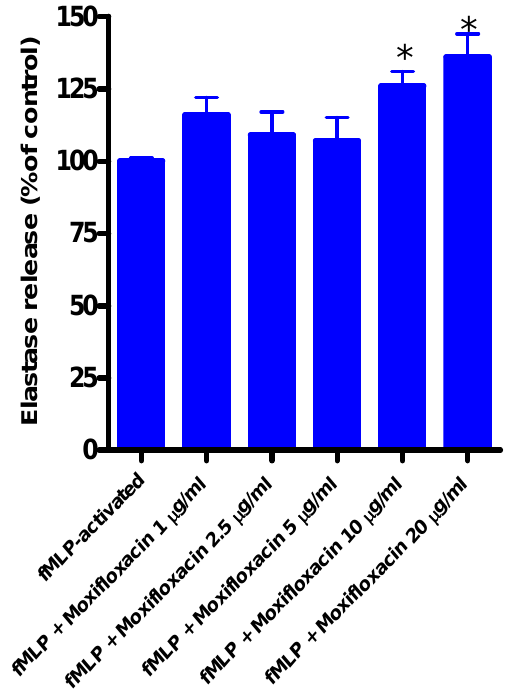
Figure 1 . Effects of moxifloxacin on the release of elastase from fMLP/CB-activated